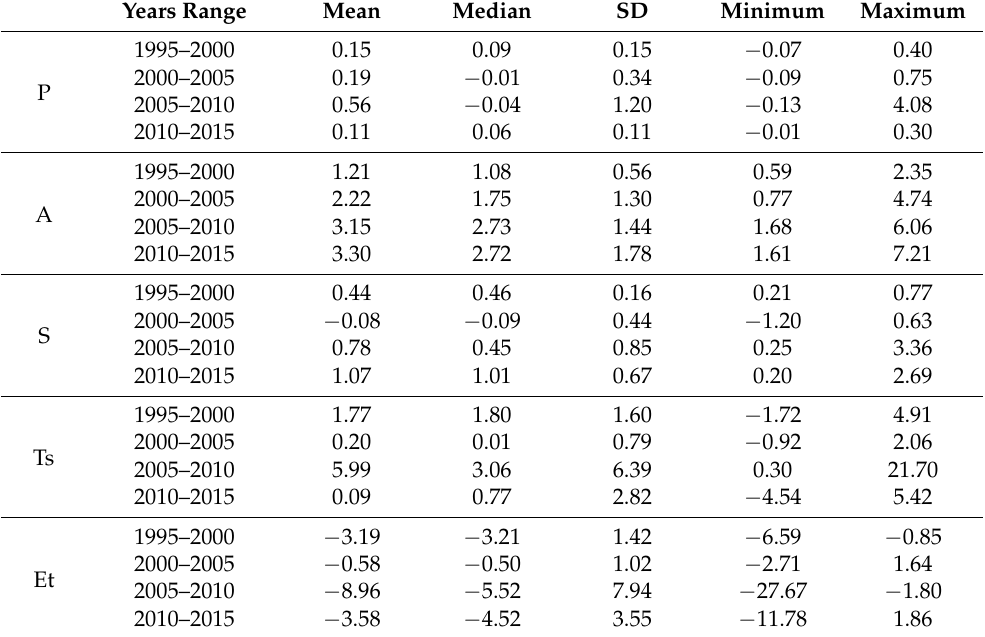
Table A3. Summary of factors’ decomposition for 13 prefecture-level cities of Jiangsu.